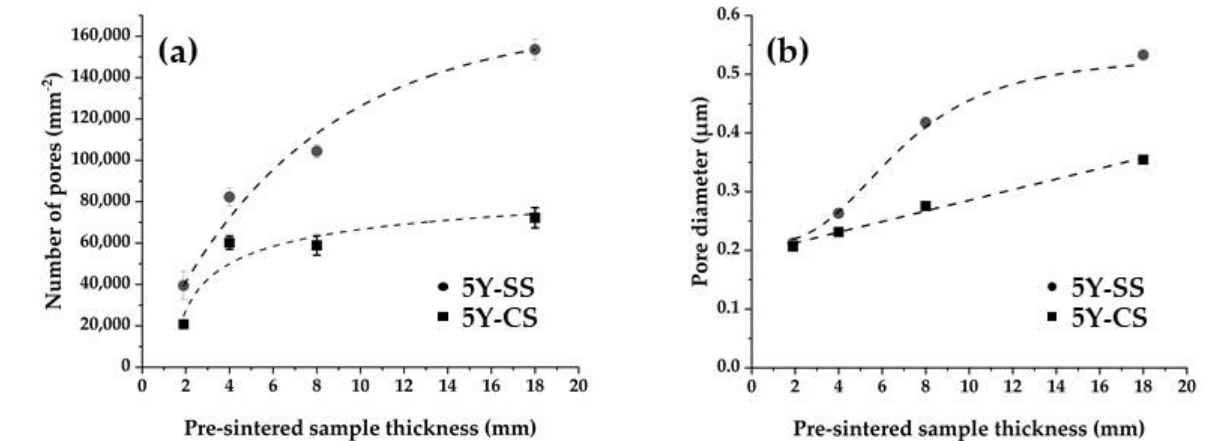
Figure 8. Relationship between the specimen’s pre-sintered thickness and ( a ) the number and ( b ) the diameter of pores.